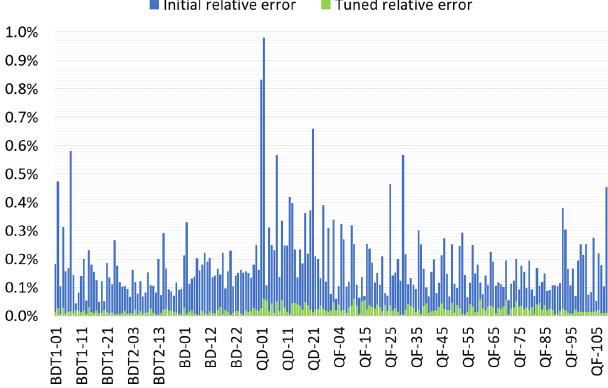
FIG. 12. Relative field errors before and after tuning.